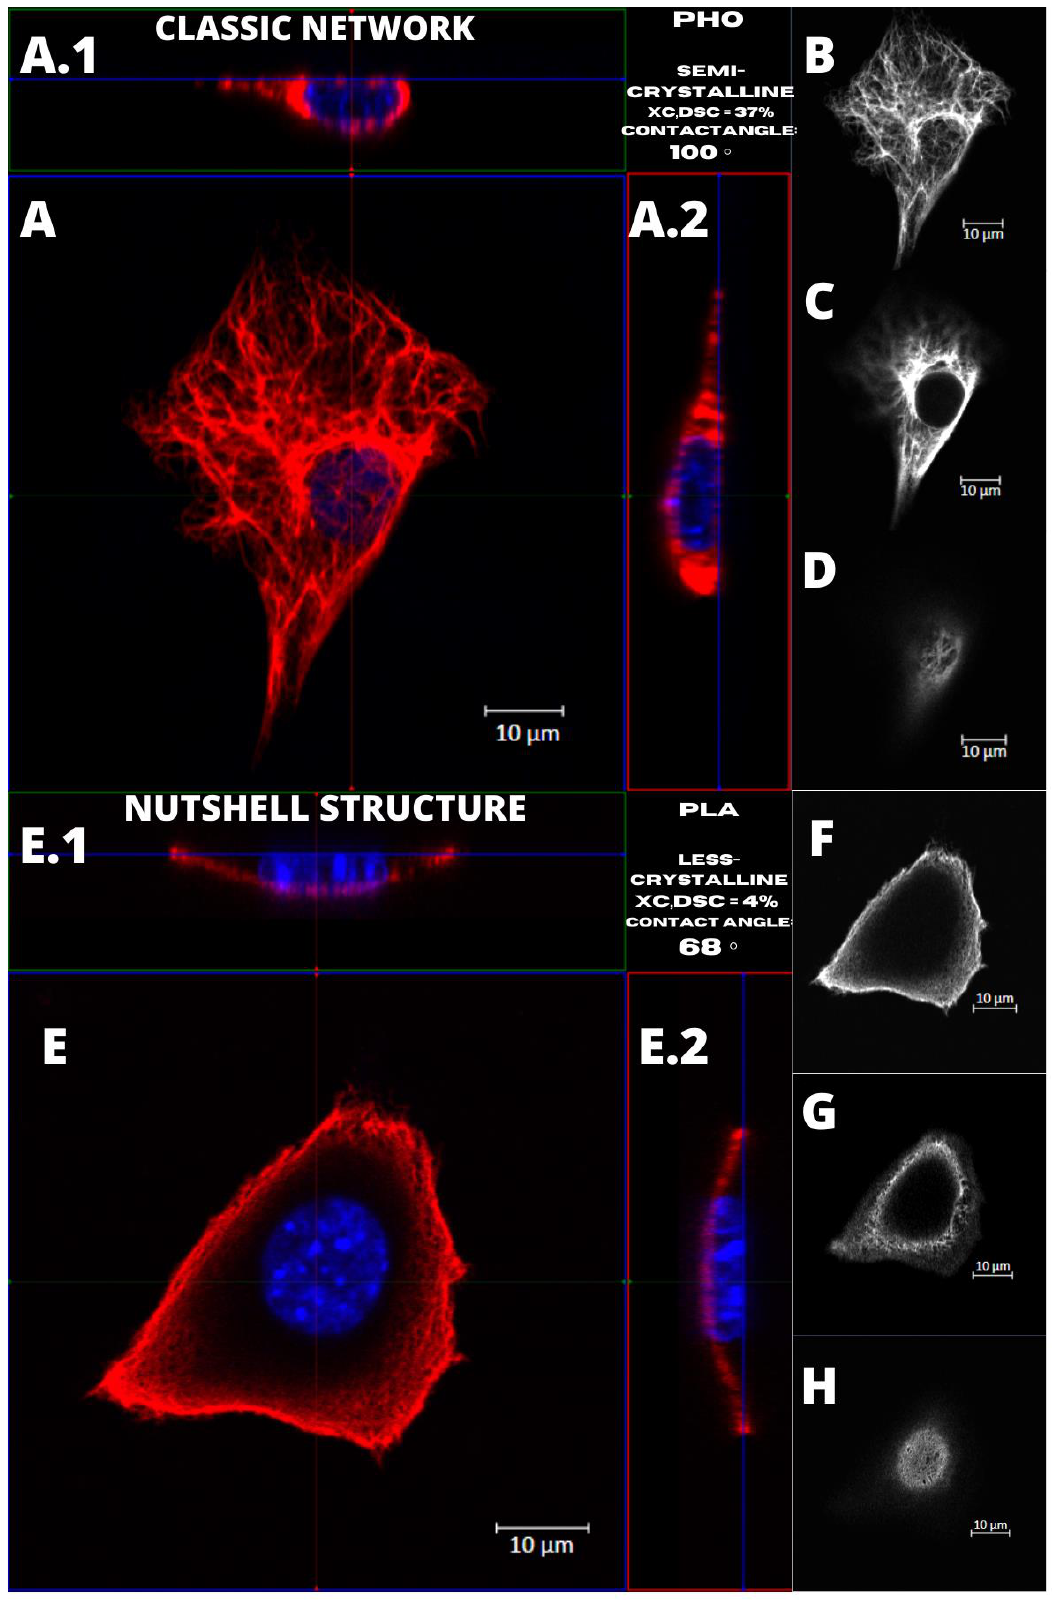
Figure 4. Comparison of the vimentin classic network and nutshell structure appearance. Cell with classic network cultured on P(3HO), cell with nutshell structure cultured on PLA. ( A , A.1 , A.2 , E , E.1 , E.2 ) Orthogonal view. ( B , F ) Single z-stack images of the bottom of the cell. ( C , G ) Single z-stack images of the middle of the cell. ( D , H ) Single z-stack images of the top of the cell.